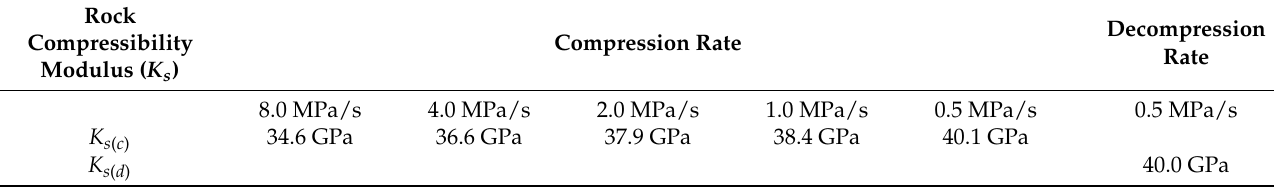
Table 2. Volumetric moduli of compressibility for compression ( K s ( c ) ) and decompression ( K s ( d ) ); SU test, Tumlin sandstone. Rock